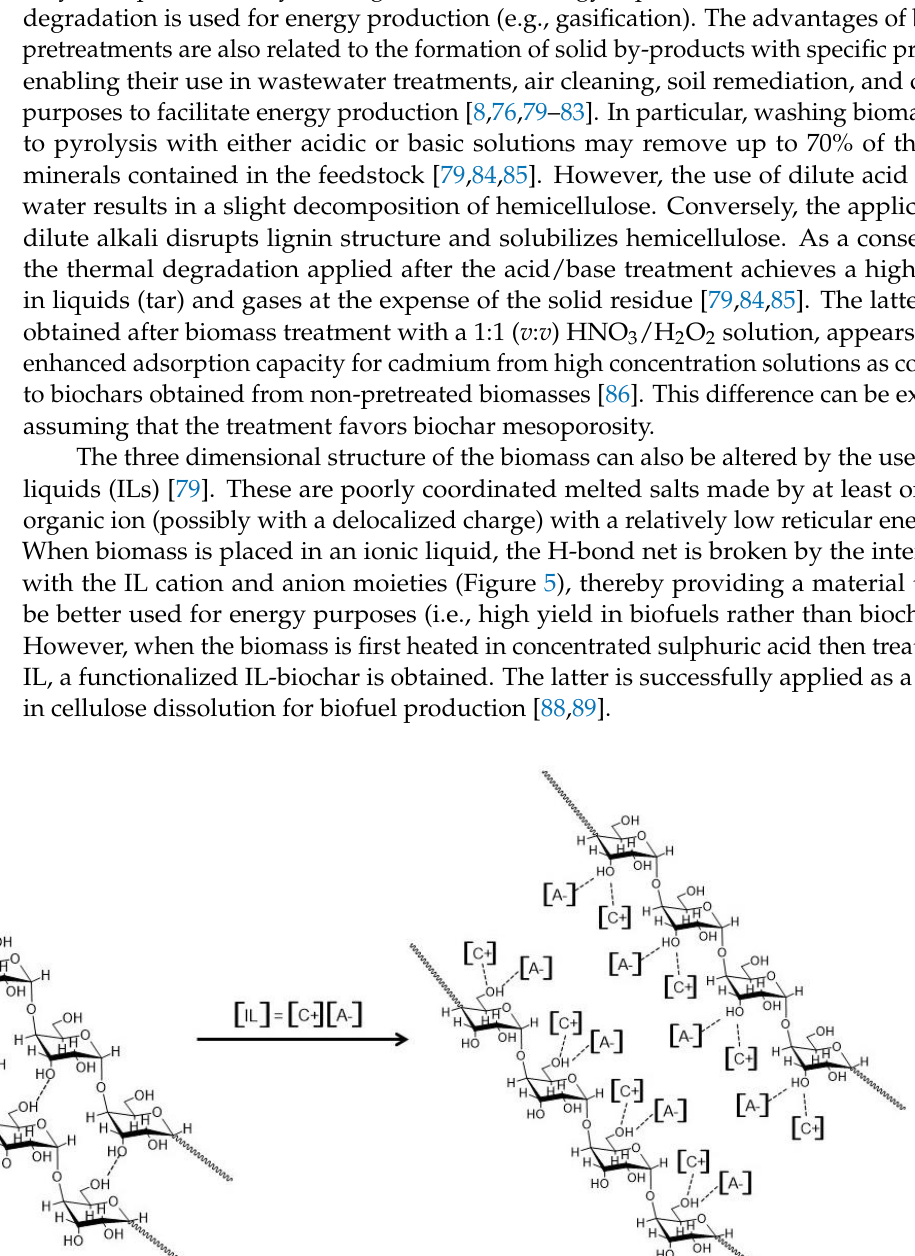
(unpublished results from the group of P.C.).